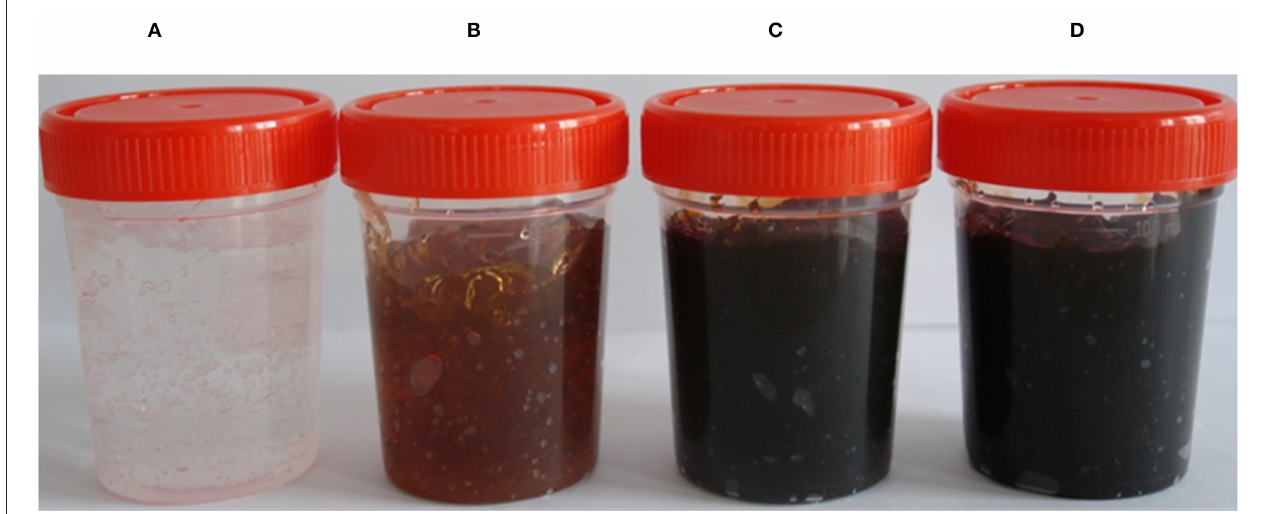
FIGURE 1 | Formulated silver nanogels of different concentrations. (A) Control (Gel base); (B) 0.1mg g − 1 ; (C) 0.5mg g − 1 ; (D) 1mg g − 1 (mg g − 1 concentration of silver NPs used for gel preparation), (Patented product, Patent No. 377757, Application No. 838/MUM/2014).